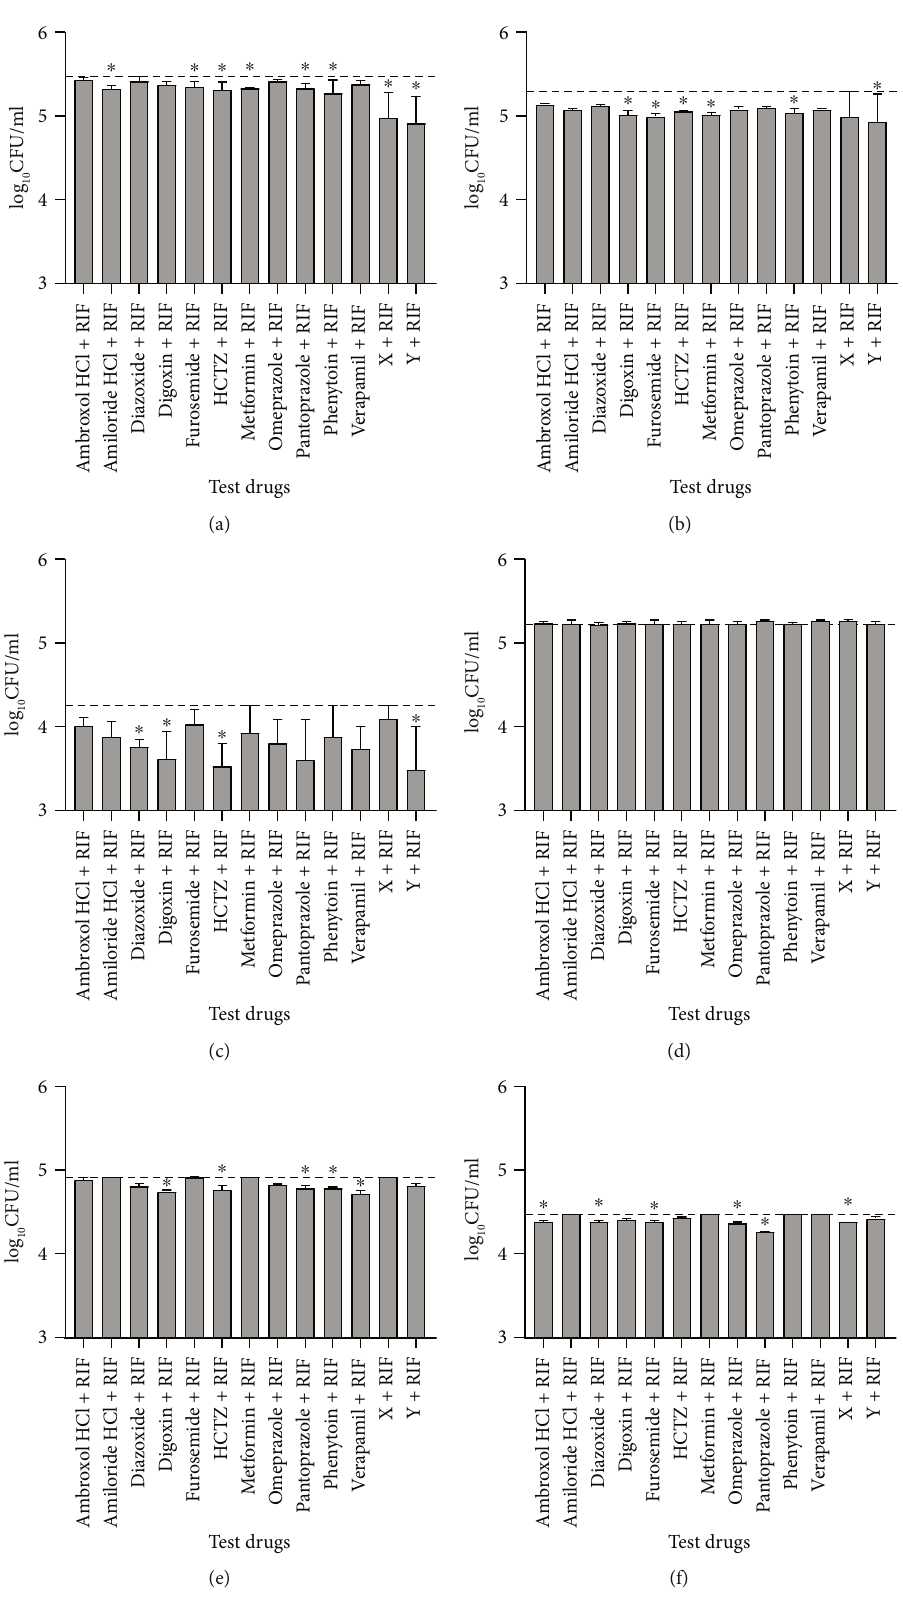
Figure 2: Median (+IQR) bacterial concentration (colony forming units/ml) after exposure of extracellular (a – c) and intracellular (d – f) M. bovis BCG to rifampicin (RIF) alone or in combination with di ff erent test drugs for 3 (a, d), 6 (b, e), or 9 (c, f) days. Dashed lines indicate CFU in cultures treated with rifampicin alone. ∗ indicates p < 0 : 05 vs. cultures treated with rifampicin only. HCTZ: